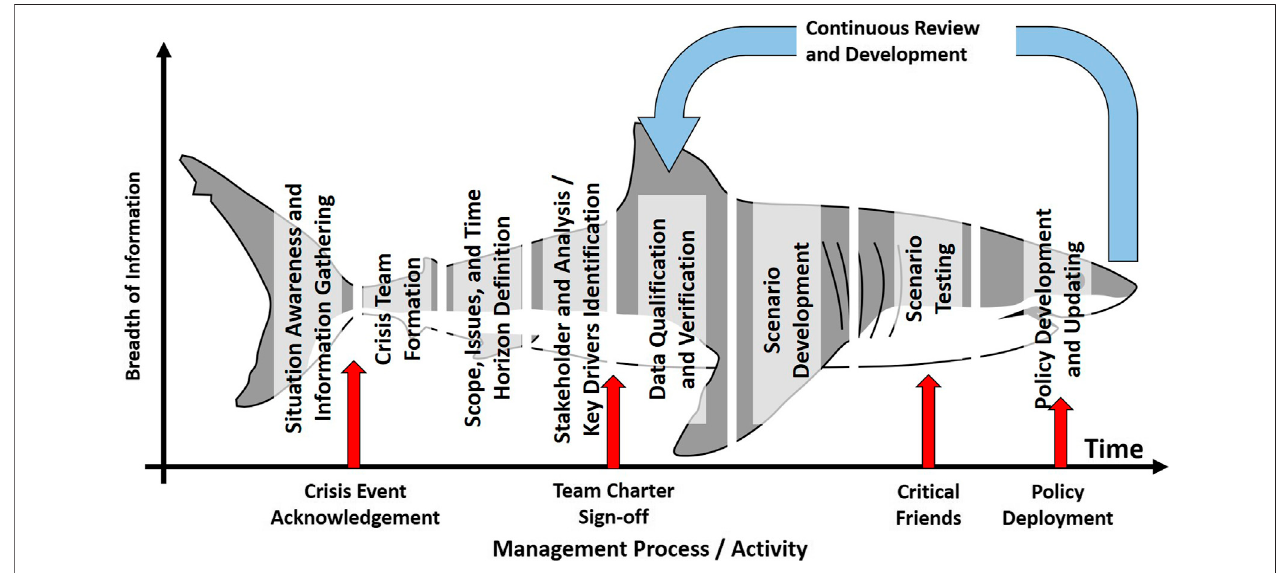
FIGURE 4 | Shark diagram of Crisis